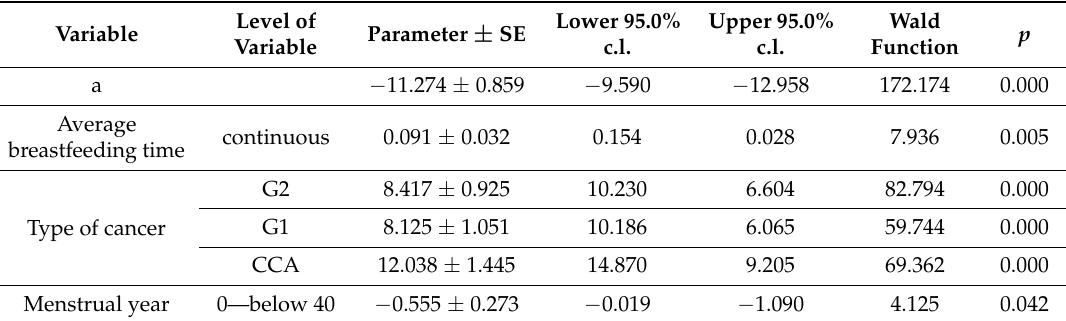
Table 3. Parameters of the best fitted model of modelled probability of AMH protein expression and studied variables; model reduced to the all significant levels of independent variables. c.l.—confident limits. a—intercept (point where the regression line crosses the